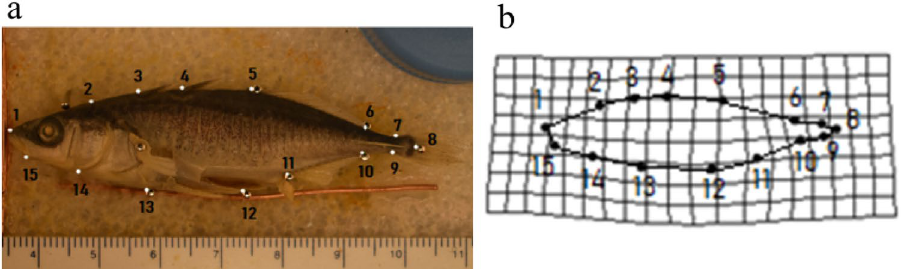
Figure 8. Analysis of stickleback body shape. Panel ( a ) shows an image of the left side of a female stickleback body sampled from the Englishman River site, with anatomical landmarks (1–15) used for geometric morphometric analysis (see methods). Panel ( b ) is a thin-plate spline deformation grid which represents variation in the shape of the specimen in panel ( a ). The deformation grid is based on the Procrustes shape coordinates, generated from a generalized Procrustes analysis using the shape landmarks shows in panel ( a ) as described in the